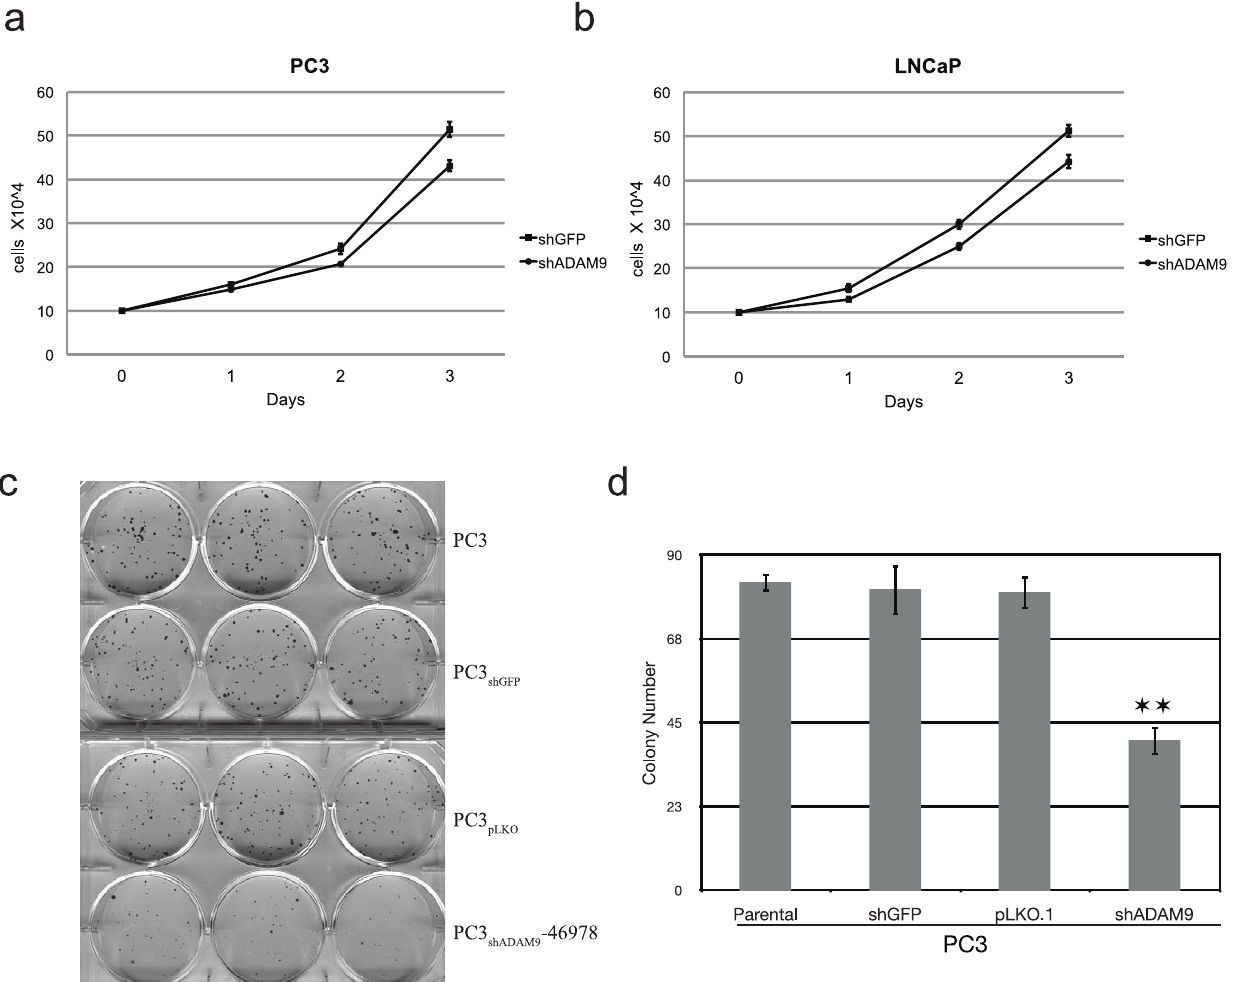
Figure 1. Knockdown of ADAM9 expression decreased prostate cancer cell proliferation. Cell proliferation decreased starting 2 days after seeding (1 6 10 4 cells/well) of ADAM9-knockdown PC3 (a) and LNCaP (b) (* Student’s t-test, p # 0.05). (c) Clonogenic cell proliferation assays of PC3, PC3 shGFP , PC3 pLKO and PC3 shADAM9 -46978 revealed decreased colonies in PC3 shADAM9 -46978. (d) Quatitative analyses of clonogenic studies demonstrated that the number of cell colonies was lower in lentiviral knockdown of ADAM9 expression compared to wild-type, mock infected, and non-target controls (** Student’s t-test, p # 0.001).